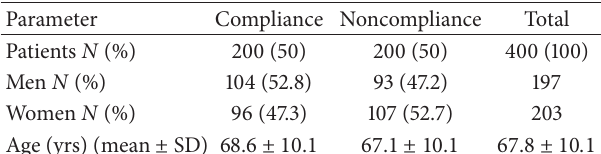
Table 1: General characteristics of the participants according to age, gender, compliance, and noncompliance to glaucoma treatment.